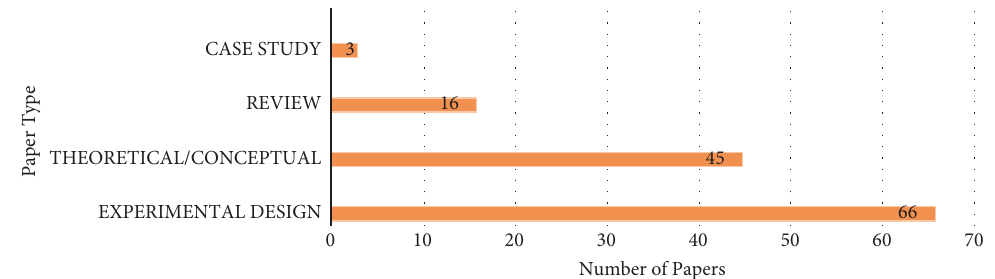
Figure 6: Types of research covered by the literature in the reviewed